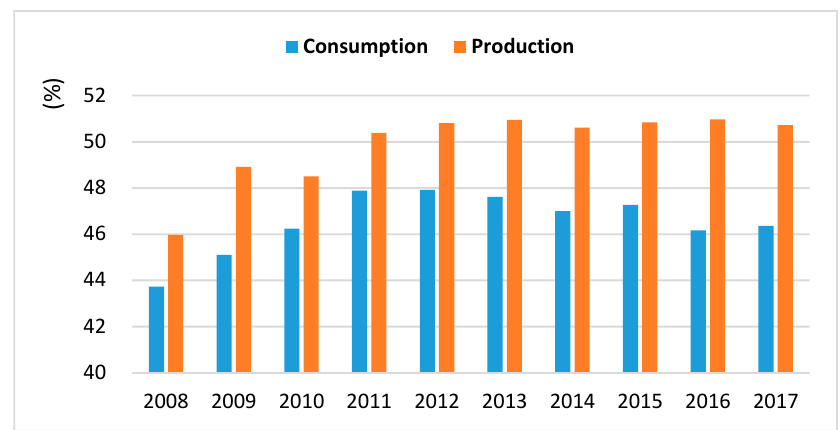
Figure 1. China’s ensured reserves of coal by province (2016).